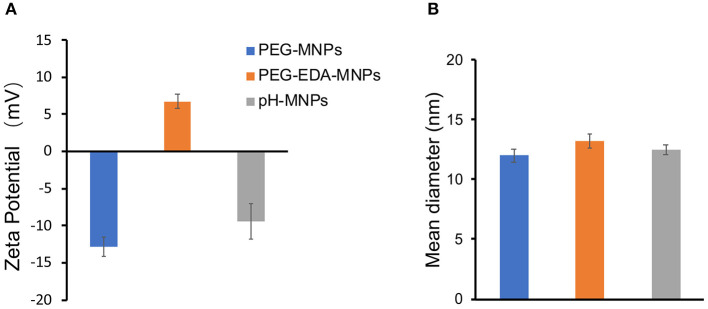
Characteristics of MNPs. (A) Zeta potential of PEG-MNPs, PEG-EDA-MNPs, and pH-MNPs. (B) Hydrodynamic size of PEG-MNPs, PEG-EDA-MNPs, and pH-MNPs. Bars represent means ± SD (n = 3). All of the samples are adjusted to neutral pH value by buffer solution.